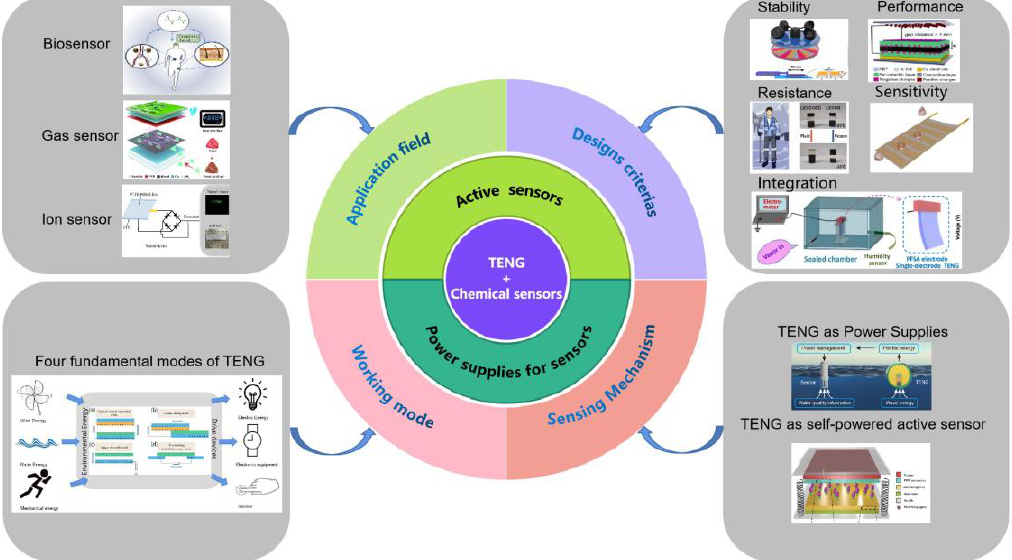
Figure 1. Recent progress of TENG-based